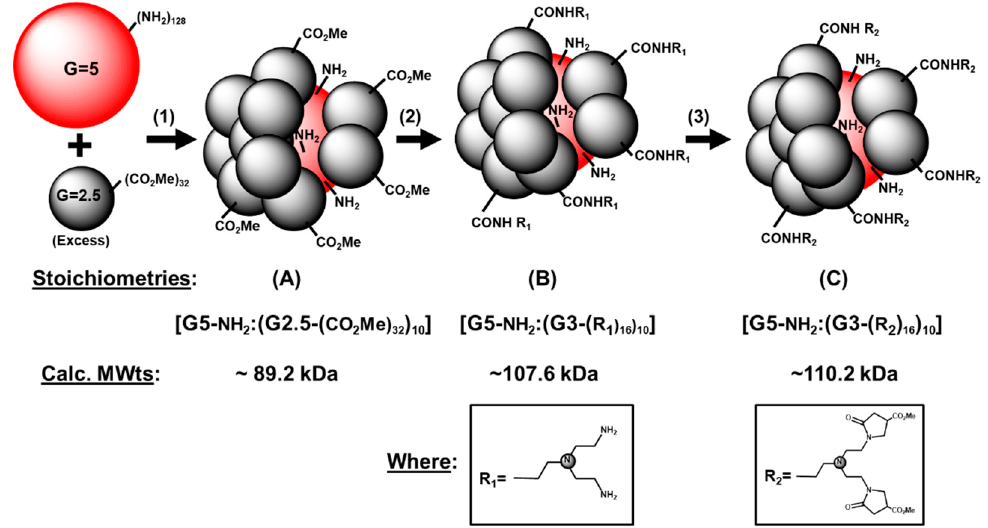
Figure 1. Reaction Conditions: Structure ( A ); Step (1), MeOH, 25 × equivalent excess of [DAB:core] dendri-[poly(amidoamine)]-(CO 2 Me) 32 , (G2.5) (DAB-1,4-diaminobutane) with [DAB:core] dendri-[poly(amidoamine)]-(NH 2 ) 128 (G5), (25 days / 40 ◦ C); Structure ( B ); Step (2), MeOH, 100 × equivalent excess of tris-[2-(aminoethyl)amine], (3 days / 4 ◦ C; 8 h / 25 ◦ C); Structure ( C ); Step (3), MeOH, dimethyl itaconate (10% excess / amino group), (12 h / 25 ◦ C). Where: R 1 = tris- N , N ′ , N ″ [2-(aminoethyl)amine] (TREN) and R 2 = N -(4-carbomethoxy) pyrrolidone terminated TREN moieties.